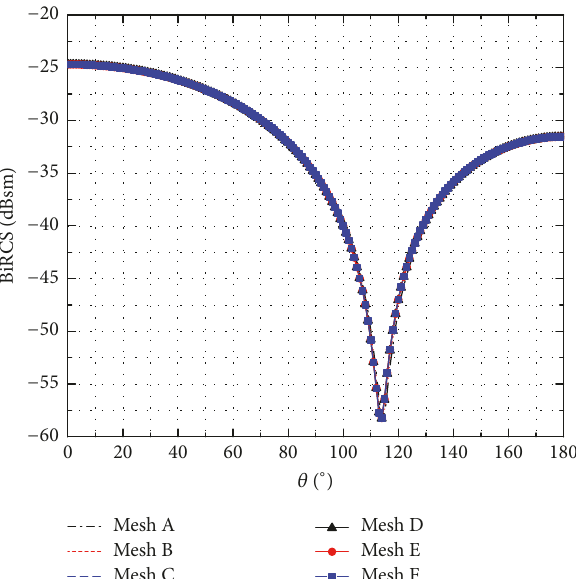
Figure 6: RMS errors of interpolation.